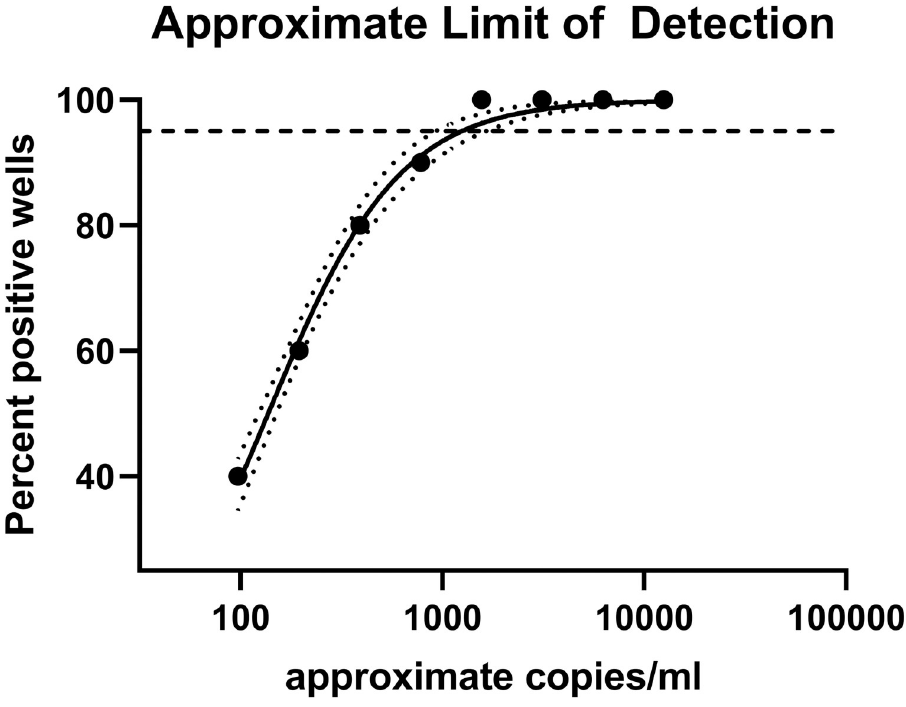
Fig 1. Approximate limit of detection of altona RealStar Yellow Fever Virus RT-PCR kit 1.0. Non-linear regression of the percent positive wells detected at approximate RNA concentrations. The dotted line on the y-axis depicts 95% detected wells. The curve-fitted dotted line indicates the 95% confidence range of the non-linear regression.